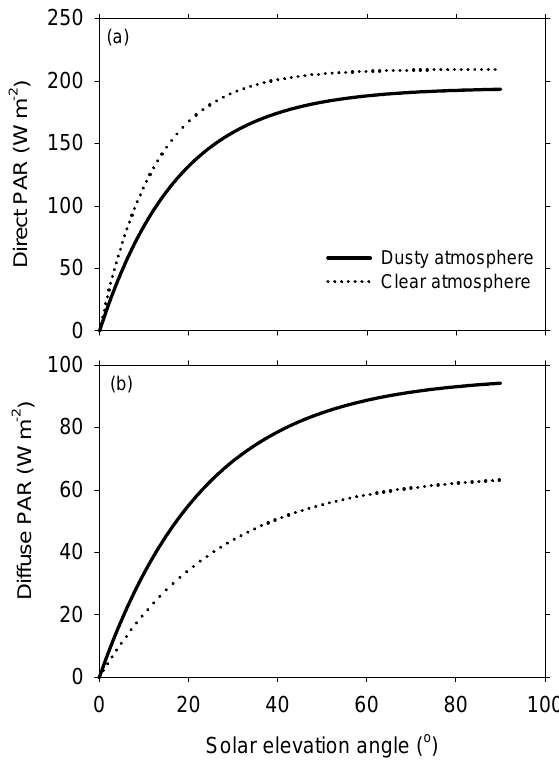
Fig. 1. Variation of direct (a) and diffuse (b) PAR as a func- tion of solar angle in dusty (1992) and clear (1994) atmospheres. The curves are given by Direct PAR, dusty atmosphere=194.7 (1- e − 0 . 05664 β ) , Diffuse PAR, dusty atmosphere=96.4 (1- e − 0 . 0423 β ) , Direct PAR, clear atmosphere=209.6 (1- e − 0 . 08061 β ) , Diffuse PAR, Figure 1 clear atmosphere=65.2(1- e − 0 . 03712 β ) , where β is the solar angle. (Wilton et al. ) Based on data from Gu et al.